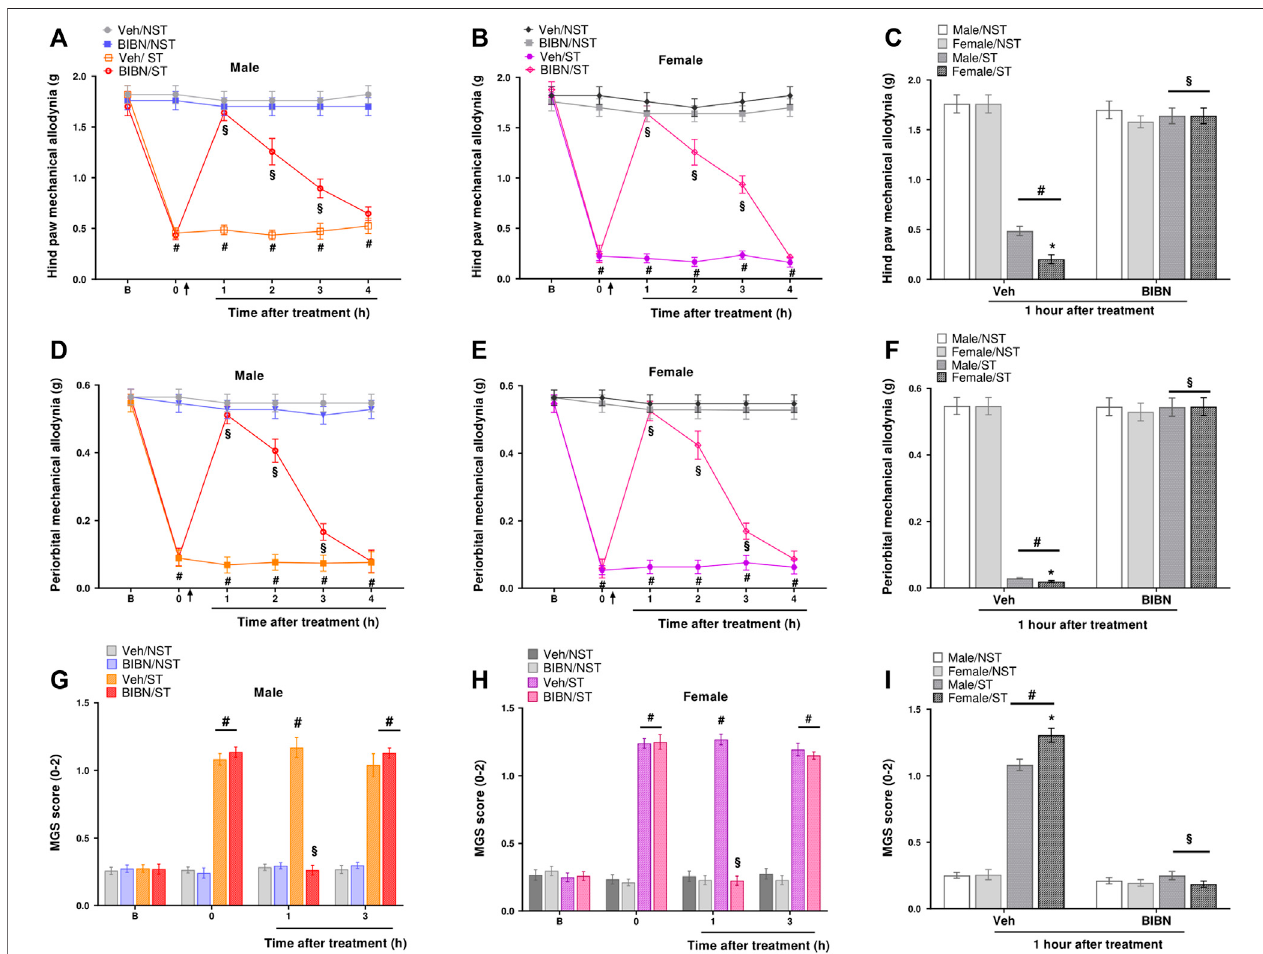
FIGURE 5 | CGRP antagonist reduced migraine-like behaviors induced by unpredictable stress model in mice. BIBN4096BS (olcegepant, 100 mg/kg) intraperitoneal (i.p.) administration reduced the (A,B) hind paw mechanical allodynia (D,E) periorbital mechanical allodynia (PMA), and (G,H) grimacing pain behavior in male and female stressed (ST) mice when compared to vehicle (Veh) treated group. Antinociceptive effect of BIBN4096BS at 1 h after treatment for (C) hind paw mechanical allodynia (F) PMA, and (I) grimacing pain behavior. Baseline measurements (described as B in the graph) were observed before induction. Time 0 represents the measures taken 7 days after ST or in the NST group. The arrow represents the treatment or veh injection. Spontaneous nociception was analyzed by the mouse grimace scale (MGS). Data are expressed as mean ± S.E.M. ( n = 8). * p < 0.05, when compared vehicle/stressed group (ST) or between the sexes within the ST group. # p < 0.05 when compared to the NST group § p < 0.05 when compared to the vehicle (Veh) treated group [repeated measures two-way ANOVA followed by Bonferroni ’ s post hoc